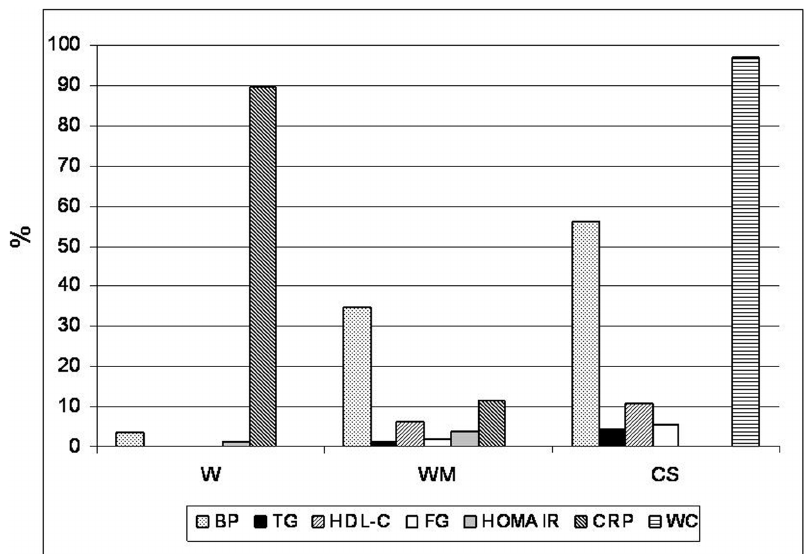
Figure 1. Comorbidities in the MHO subjects by W (Wildman), WM (Wildman modified) and CS (Consensus Societies) criteria according to the data shown in Table 1. BP: Elevated Blood Pressure, TG: Elevated Triglycerides, HDL-C: Decreased HDL-C; FG: Elevated Fasting Glucose, HOMA IR: Elevated Homeostasis Model Assessment Insulin Resistance, CRP: Elevated C Reactive Protein, WC: Large Waist Circumference.